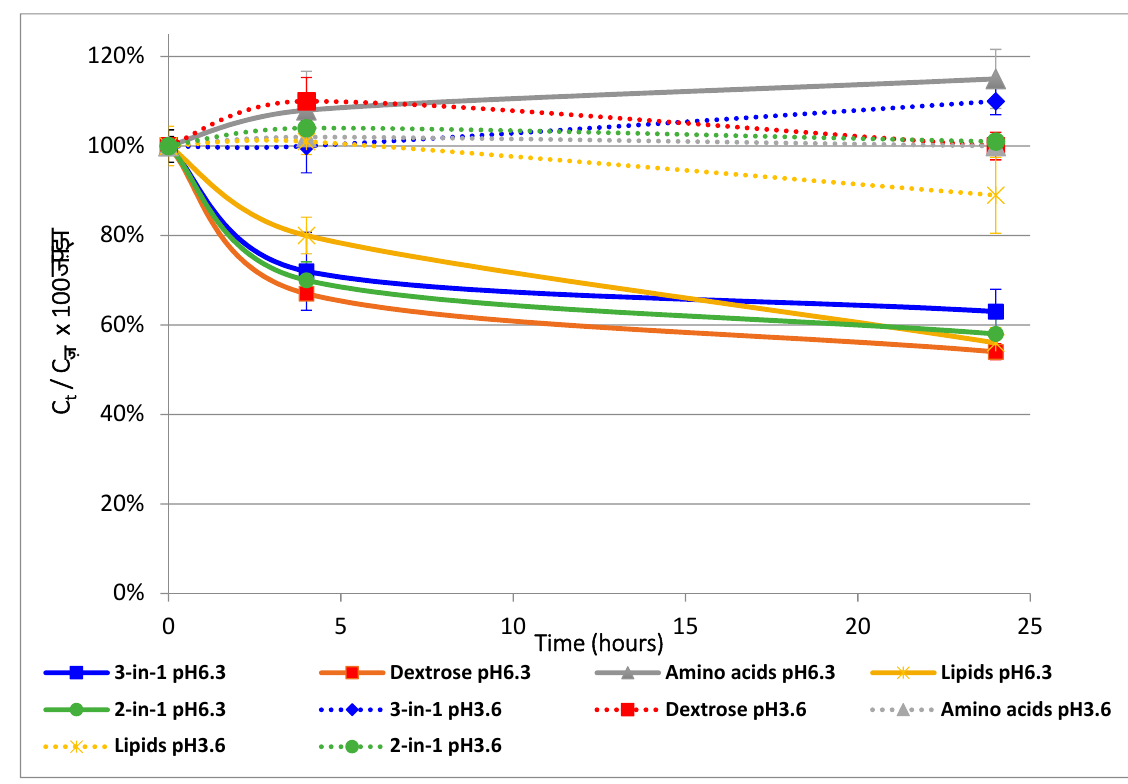
Figure 5. Changing of insulin content in PN admixtures at various pH over time. Continuous line and dotted line correspond, respectively, to pH 6.3 and 3.6. Insulin concentration remained stable at pH 6.3, whereas it decreased at pH 3.6, except in the amino acid solution.